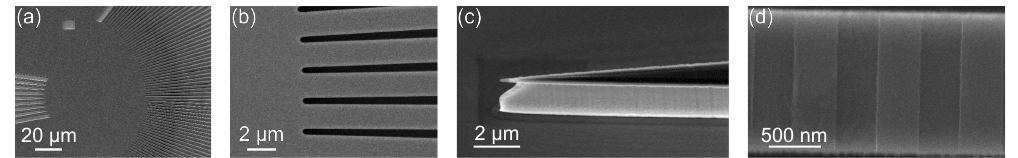
Figure 3. SEMs of the ( a ) star coupler of an AWG, ( b ) transition between the free-propagation region of the star coupler to the arrayed waveguides of an AWG, ( c ) slanted view of a QCL taper tip before etching the n -QC structure, where the top layer is the SiO 2 hardmask, and ( d ) a grating etched in the top of a Si waveguide before bonding the QCL.